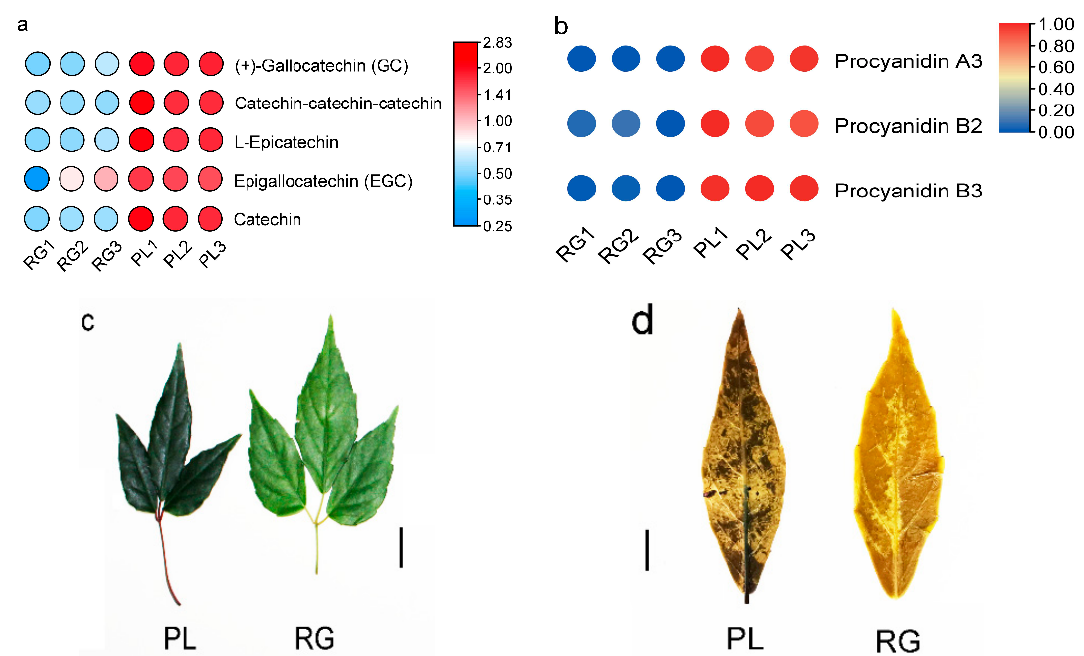
Figure 4. Predicted annotations of specific metabolite PAs detected in the leaf of T. hemsleyanum . ( a ) The content of catechins and its derivatives in the leaves of RG and PL (VI P > 1); ( b ) The content of PAs in the leaves of RG and PL (VIP > 1); ( c ) The phenotype of leaf color in the different ecotypes of T. hemsleyanum (left panel: PL; right panel: RG); ( d ) Comparison of PAs content in PL and RG ecotypes of T. hemsleyanum through DMACA staining method.